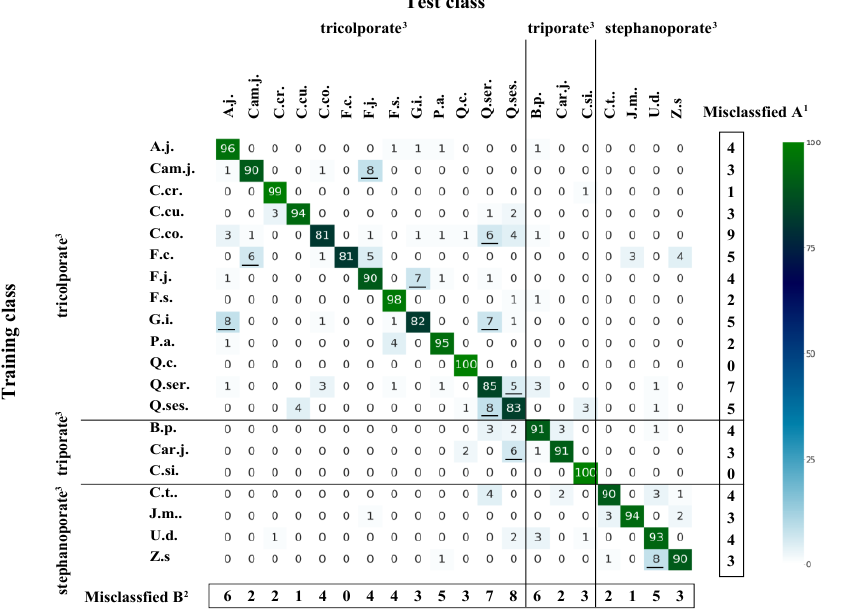
Figure 3. Heatmap of misclassification patterns according to tree species and pollen type. Results were obtained using the AlexNet algorithm without data augmentation using focal point D and 200 epochs. Values are the sums of 10 simulation results. Underlining indicates the 10 most frequent cases. 1 Number of tree species misclassified, 2 number of times a species was misclassified as a positive example of another tree species, 3 pollen types (Morita [26]).